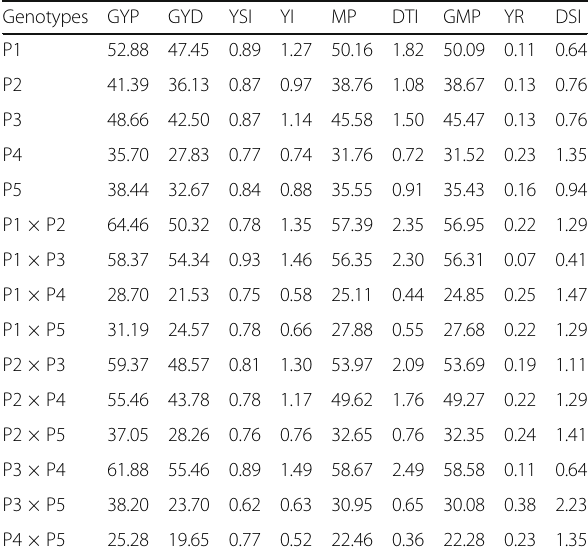
Table 9 Calculated the tolerance indices parameters for the sorghum genotypes especially for grain yield trait under the two treatments of irrigation Genotypes